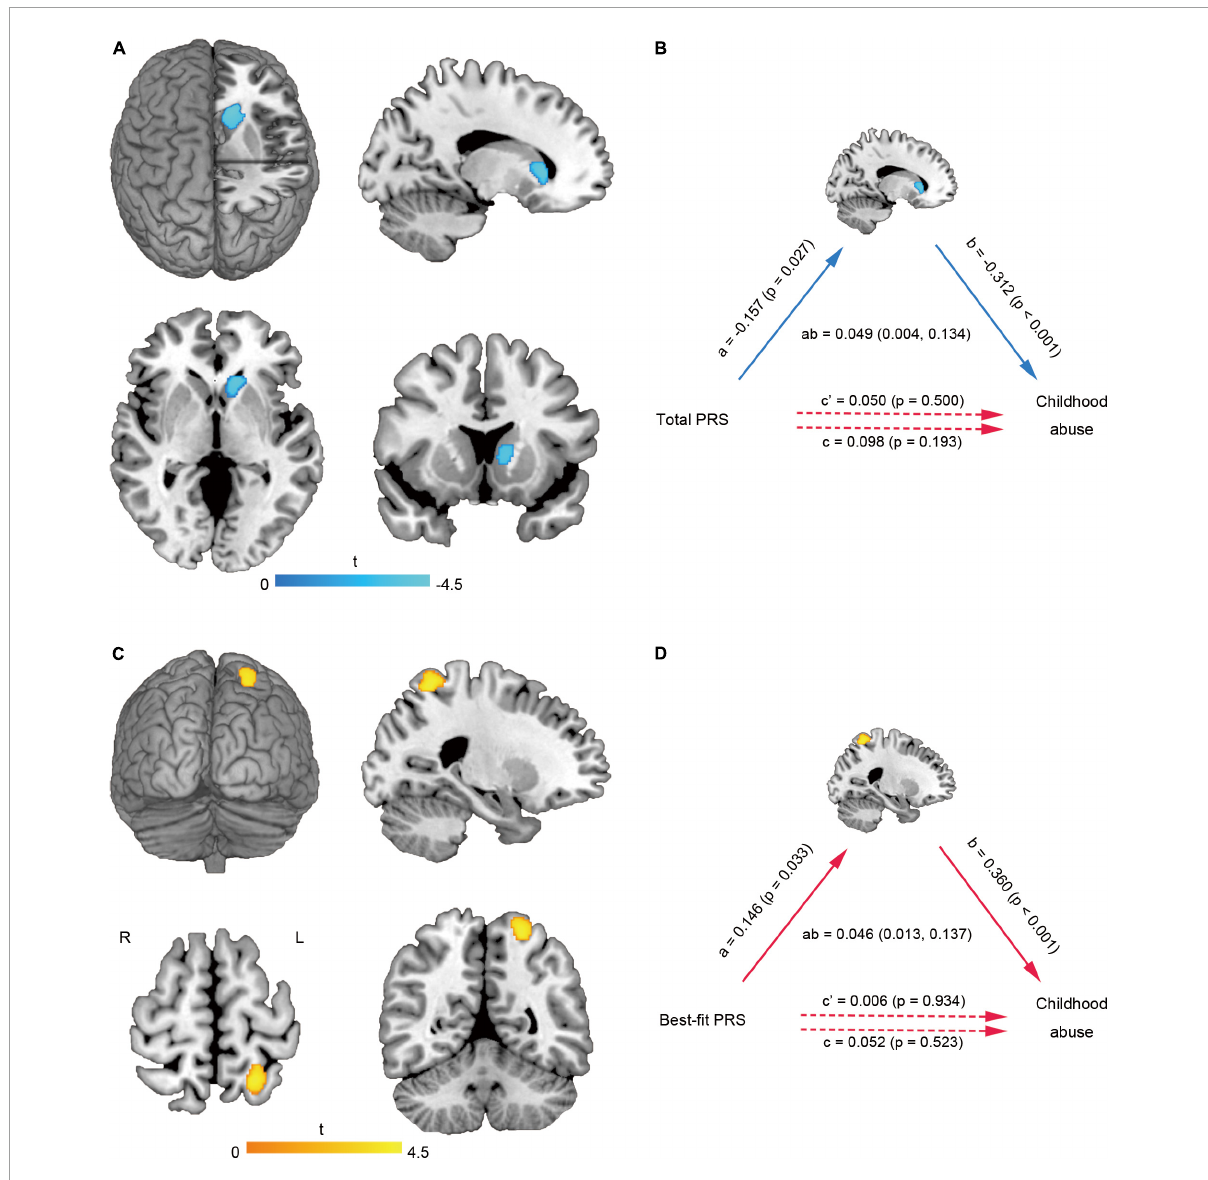
FIGURE2 Brain gray matter alterations related to childhood abuse and mediation analysis. The GMV of left caudate (A) was negatively correlated with the total abuse score. The left caudate changes mediated the effect of total PRS on childhood abuse score (B) . The GMV of left superior parietal lobule (C) was positively correlated with the total abuse score. The left superior parietal lobule changes mediated the effect of best-fit PRS on childhood abuse score (D) . GMV, gray matter volume; L, left; PRS, polygenic risk score; R,